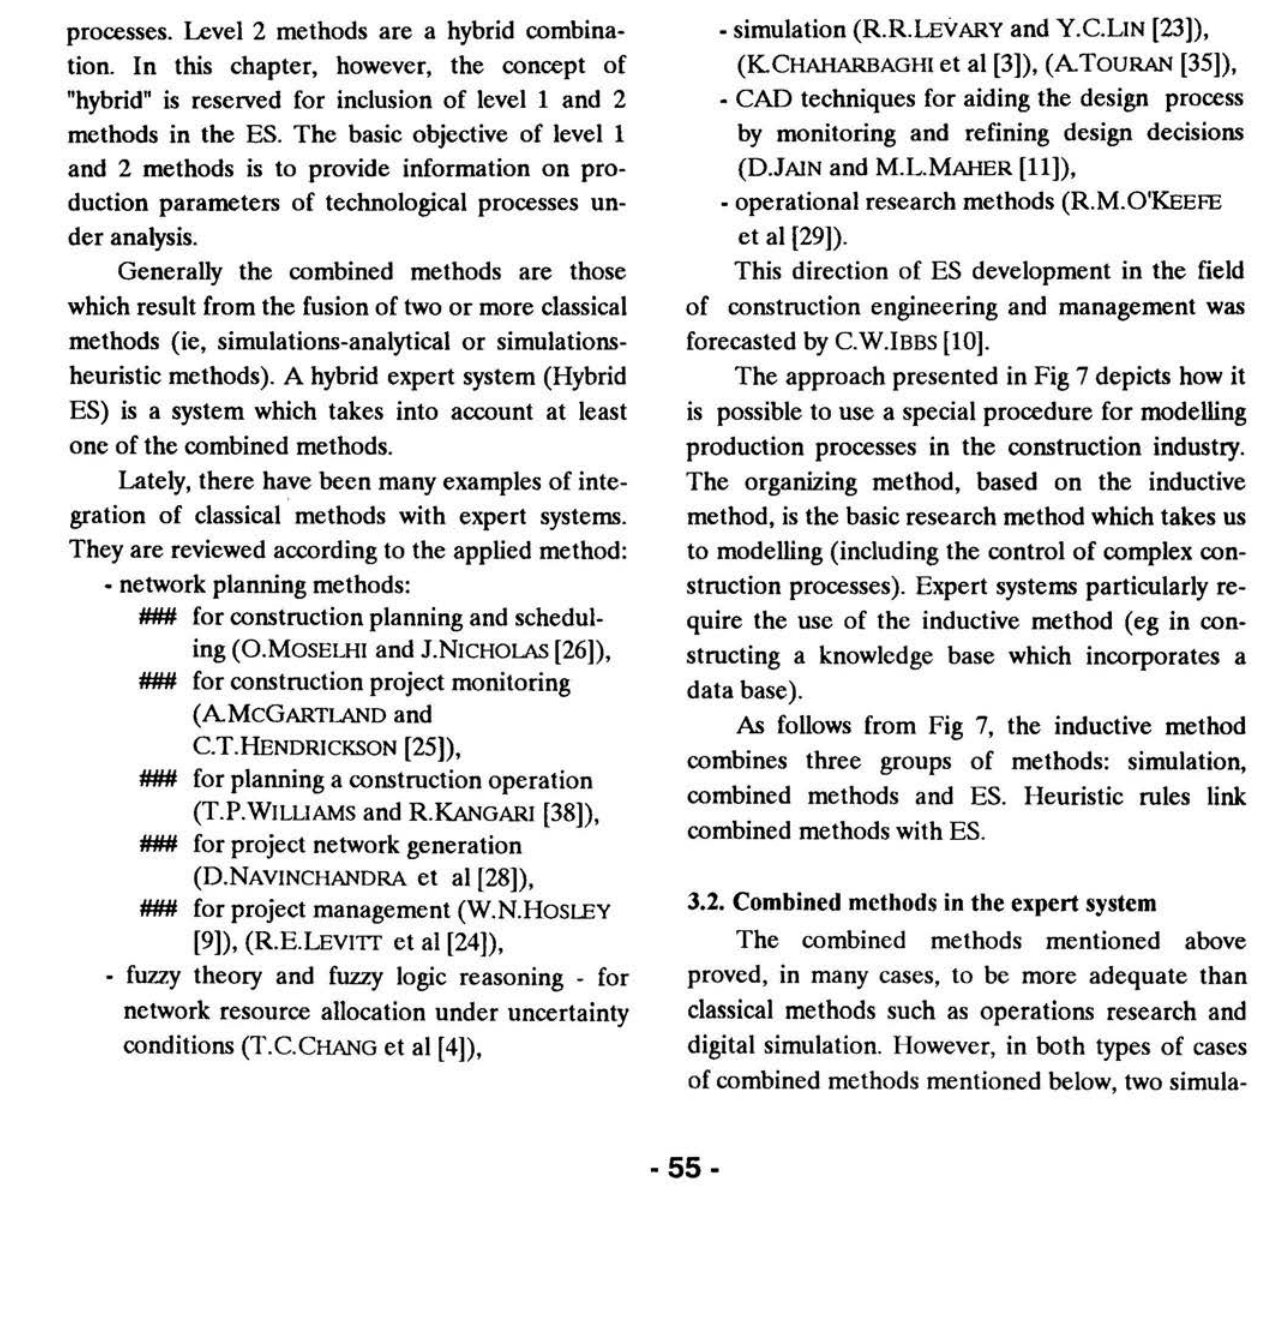
Fig 6. Interface between classical methods, combined methods and the expert